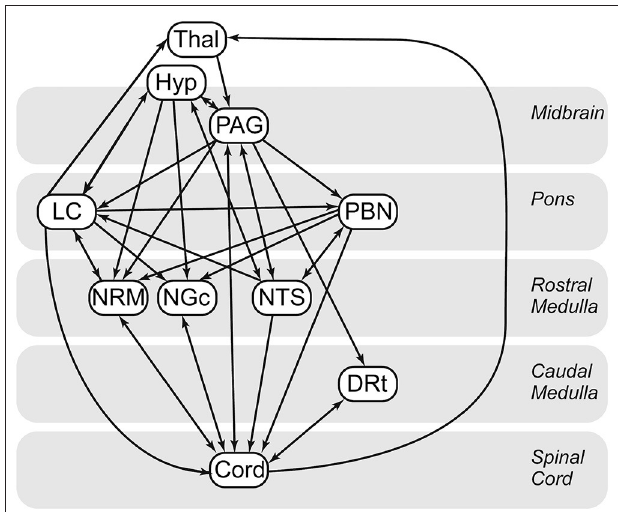
FIGURE 1 | Anatomical model of the regions and connections used for the structural equation modeling (SEM) analysis.